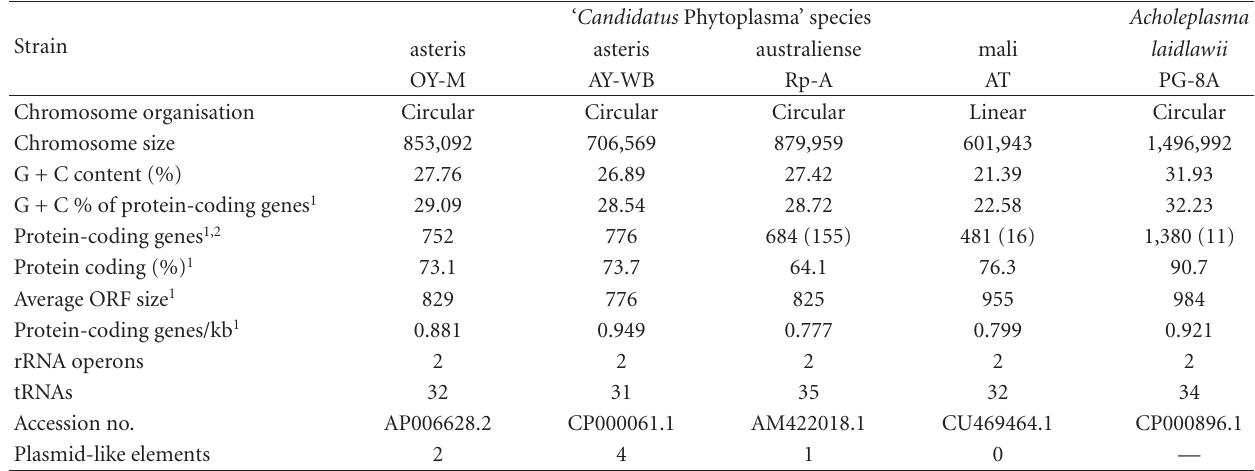
Table 1: Overview of the four complete phytoplasma genomes and A. laidlawii . Strain Circular Circular Circular Linear